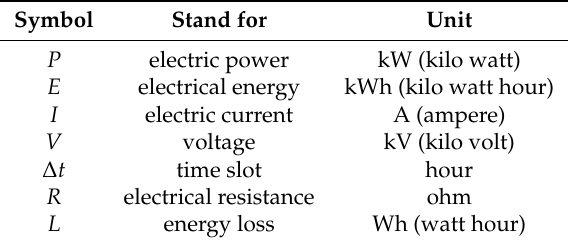
Table 1. The symbols used in energy loss